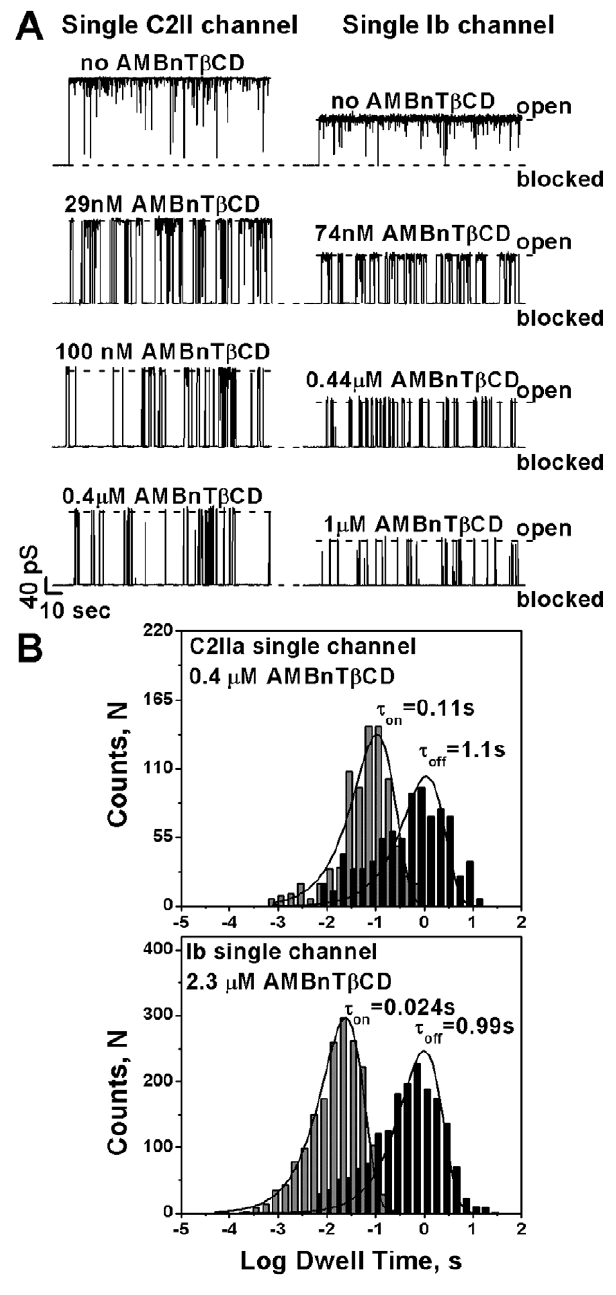
Figure 9. AMBnTßCD blocks the single pores formed by C2IIa and Ib in planar lipid membranes. A . Currents through single C2IIa (left) and Ib (right) channels at 50 mV applied voltage. The two topmost tracks represent the AMBnTßCD-free control experiments. The fast flickering between open and closed states (1/f noise) was mostly but not completely removed here by averaging over 100-ms time interval. In the presence of increasing AMBnTßCD, the channels were spontaneously blocked (three lower current tracks). The dashed lines represent zero current levels. B . Typical time histograms of AMBnTßCD- induced C2IIa (top) and Ib (bottom) current fluctuations. Original current recordings collected with 15 kHz filter and 50 kHz sampling were additionally filtered with a 300 Hz filter to exclude most of the high-frequency 1/f events. T off represents the time channels spent in the blocked state and T on is the time between successful blockages. Data were fitted by direct single-exponential (i.e. log probability) fitting [79]. The fits were obtained using variable metrics as a search method and maximum likelihood as a minimization method.